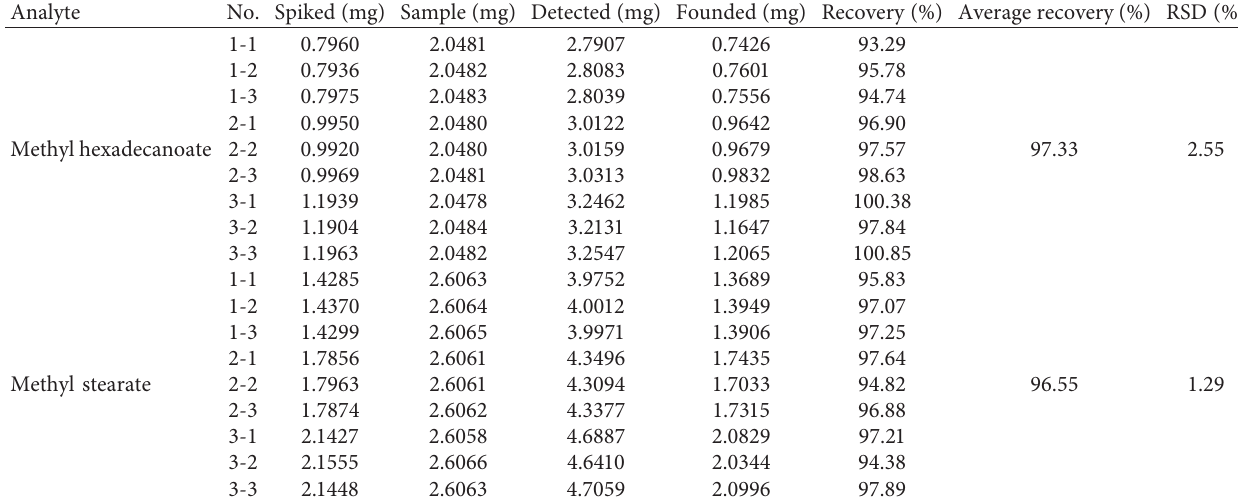
Table 1: Recoveries of methyl hexadecanoate and methyl stearate in chlorinated butyl rubber stoppers.